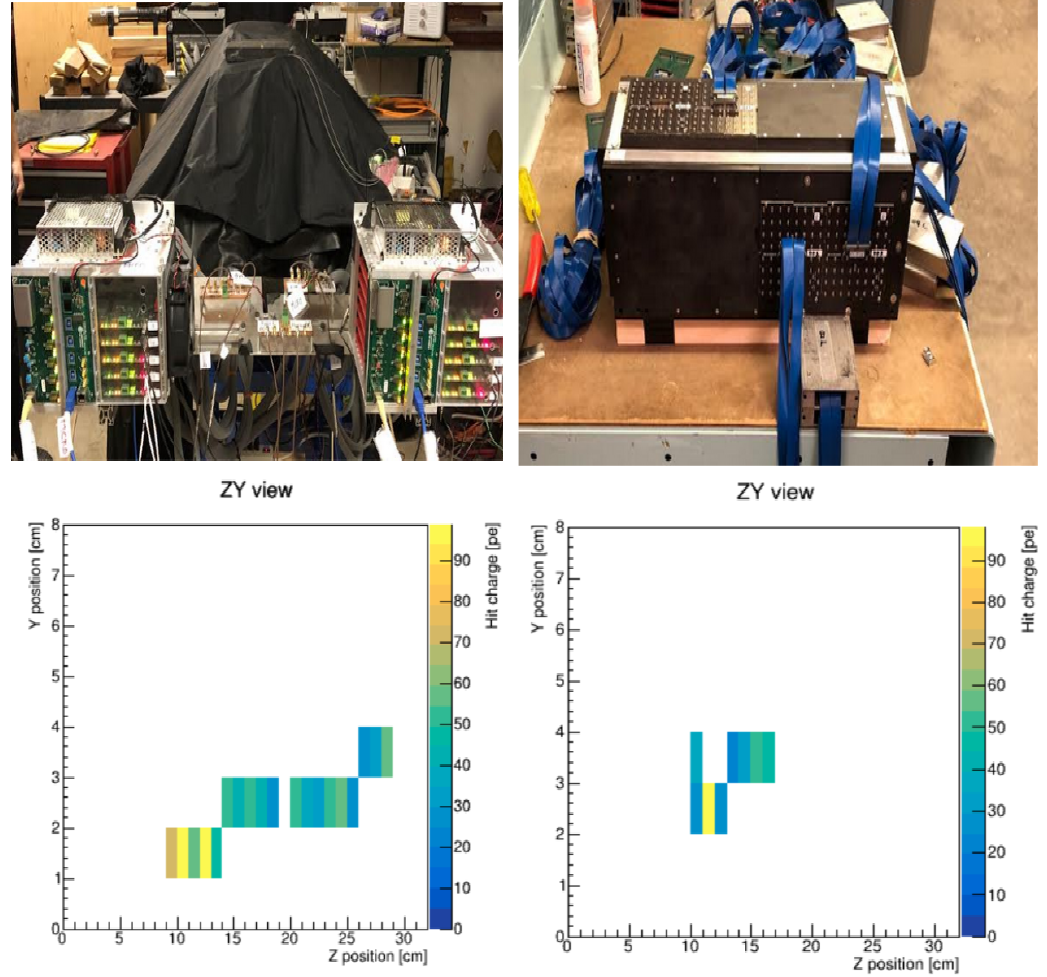
Figure 126. Photos of prototypes exposed in the Los Alamos National Lab neutron beam test facility and neutron-induced hit candidates in US-Japan prototype. ( Top Left ): SuperFGD prototype. ( Top Right ): US-Japan prototype. ( Bottom ): Neutron-induced hit candidates in the US-Japan prototype. Each candidate has three 2D views and only YZ views are shown